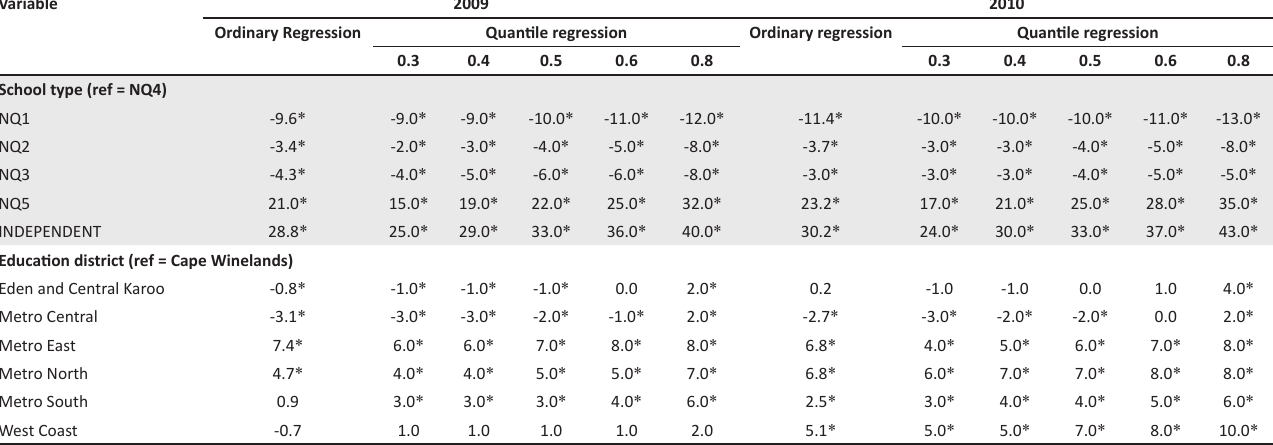
TABLE 1a: Results from the estimation of the determinants of learner marks in the National Senior Certificate mathematics.